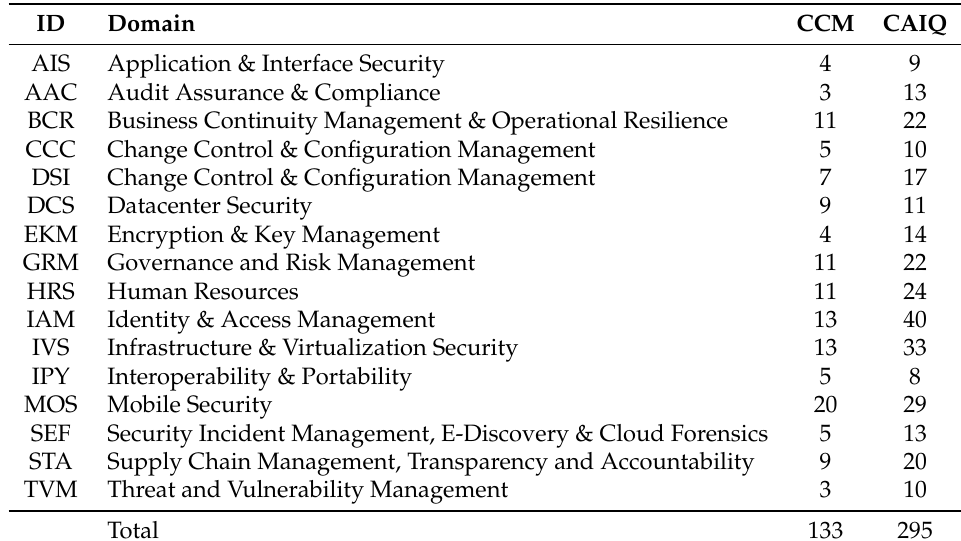
Table 3. Cloud Controls Matrix (CCM)-Item and CAIQ-Question Numbers per Domain (version